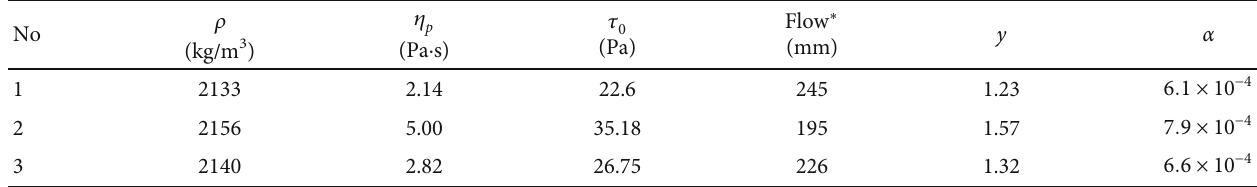
Table 2: Measured data of minislump